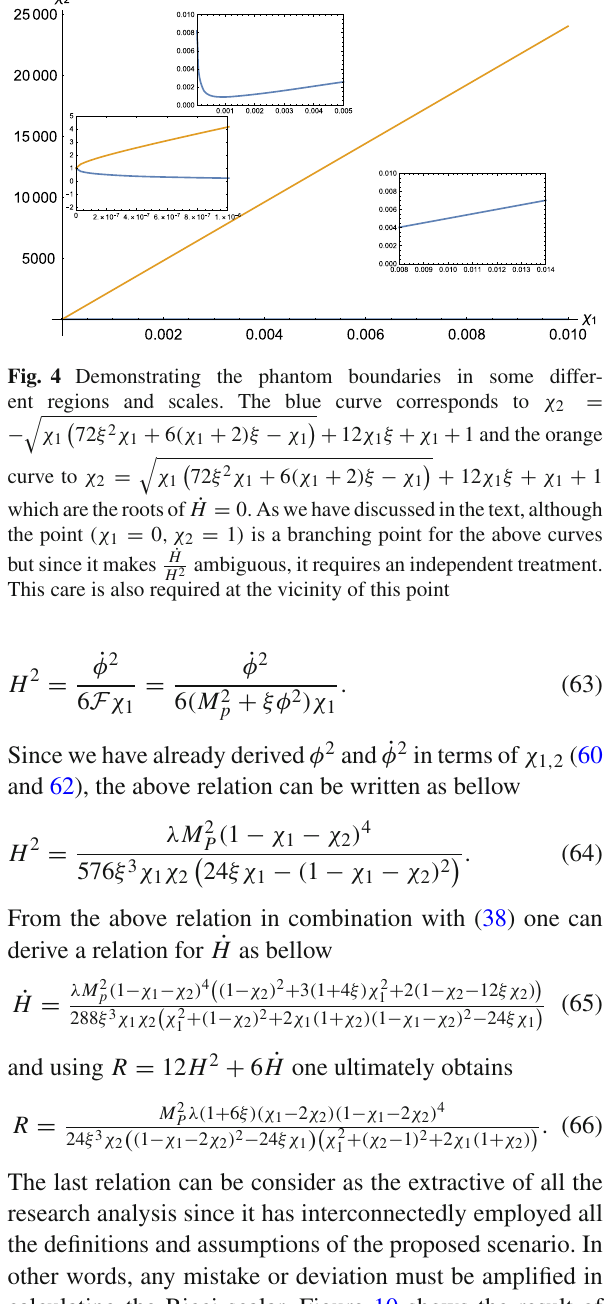
line segment but never reach it. That is because moving on the = 1 − χ χ 2 1 line segment means that